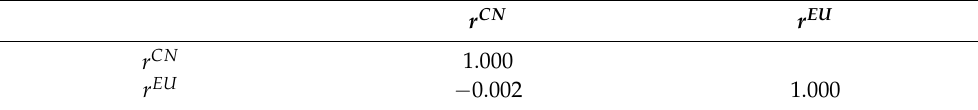
Table 2. Pairwise correlation.